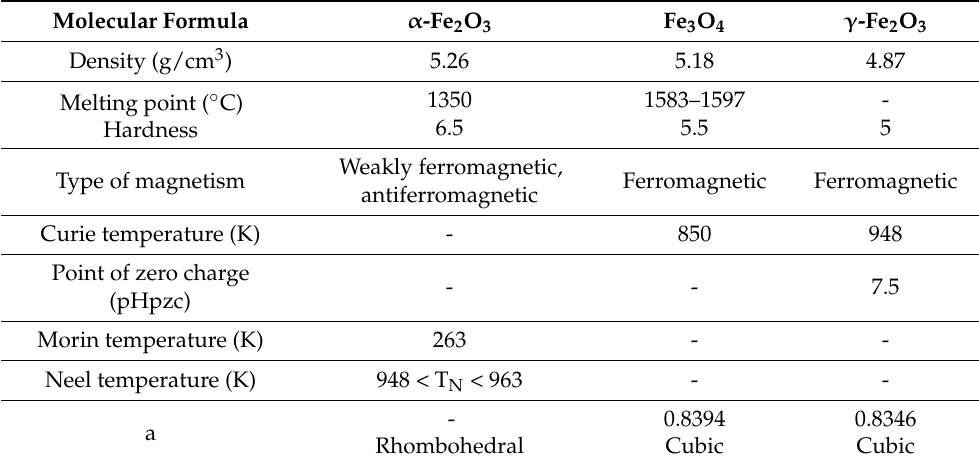
Table 3. Physical and magnetic properties of iron oxide